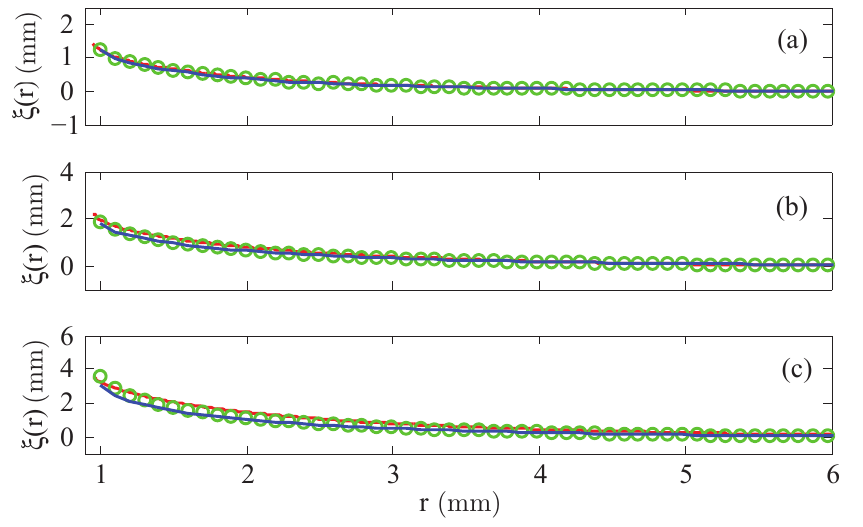
Figure 6. Calculated menisci of the magnetic fluid EMG 909 for a nonlinear law ( ) and linear law of magnetisation with χ = 0.61 ( ◦ ) versus the experimentally determined surfaces ( ). ( a ) H = 3.35 kA/m, ( b ) H = 7.54 kA/m and ( c ) H = 11.73 kA/m at R = 0.95 mm.